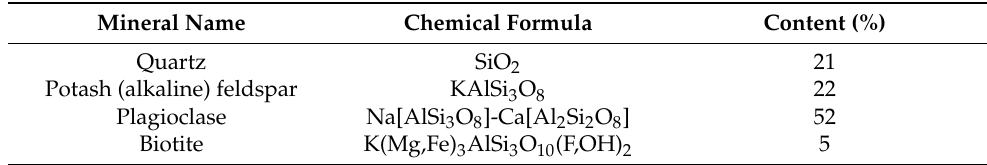
Table 1. Mineral composition of the filter